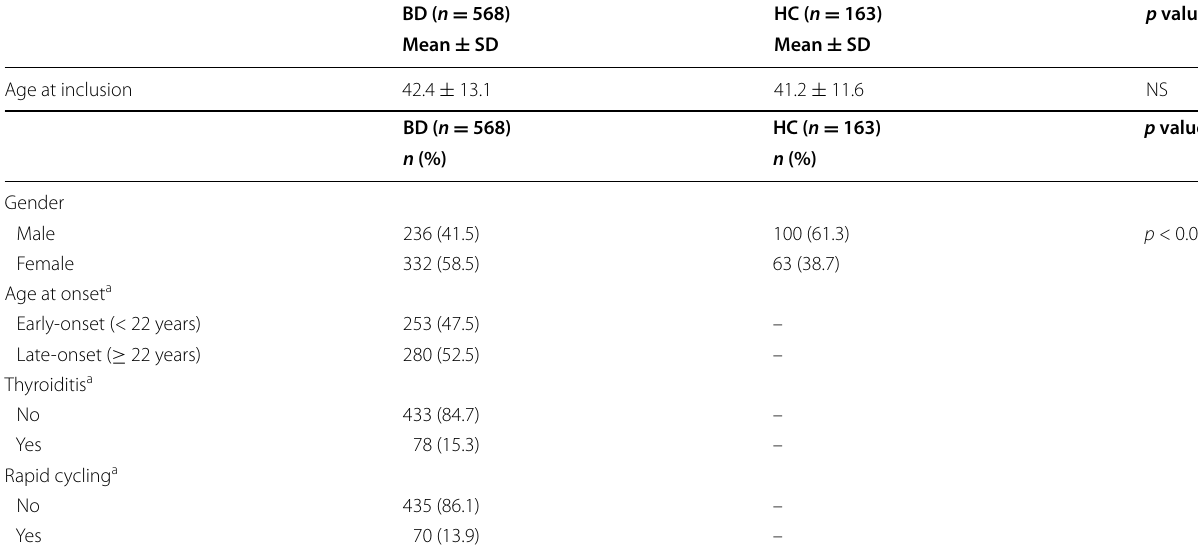
BD bipolar disorder, HC healthy controls, SD standard deviation, NS non-significant a Data not available for all